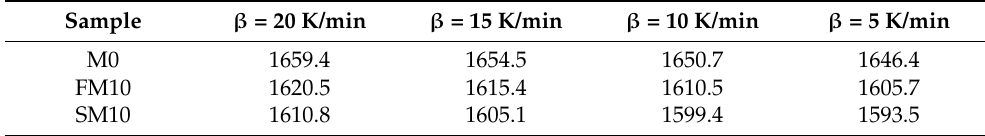
Table 4. The temperatures of crystallization peak (K) in DSC curves with different heat rates.